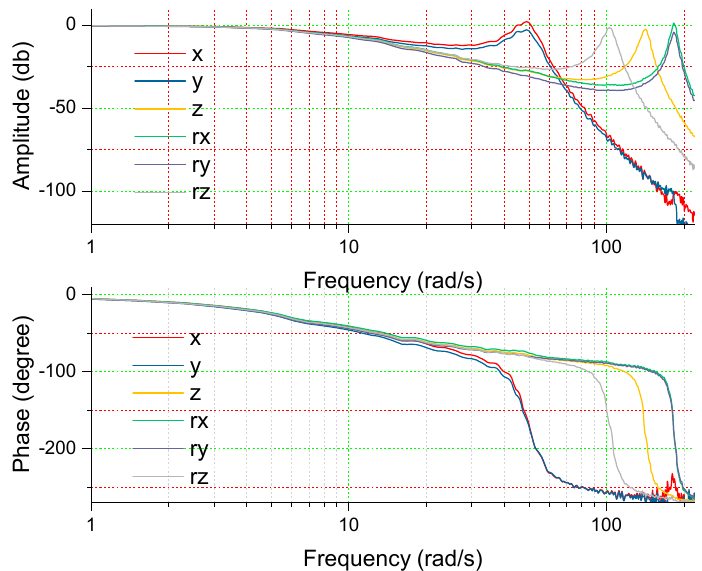
Figure 7. Bode diagram of the rigid simulation model.